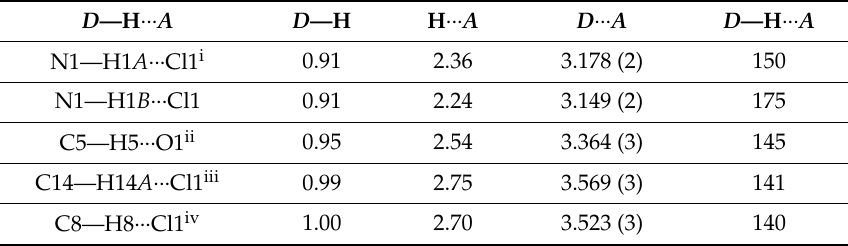
hydrochloride ( 2 ), showing the atom-labelling scheme. Table 3. Hydrogen-bond geometry (Å, ◦ ) for Compound 2 .